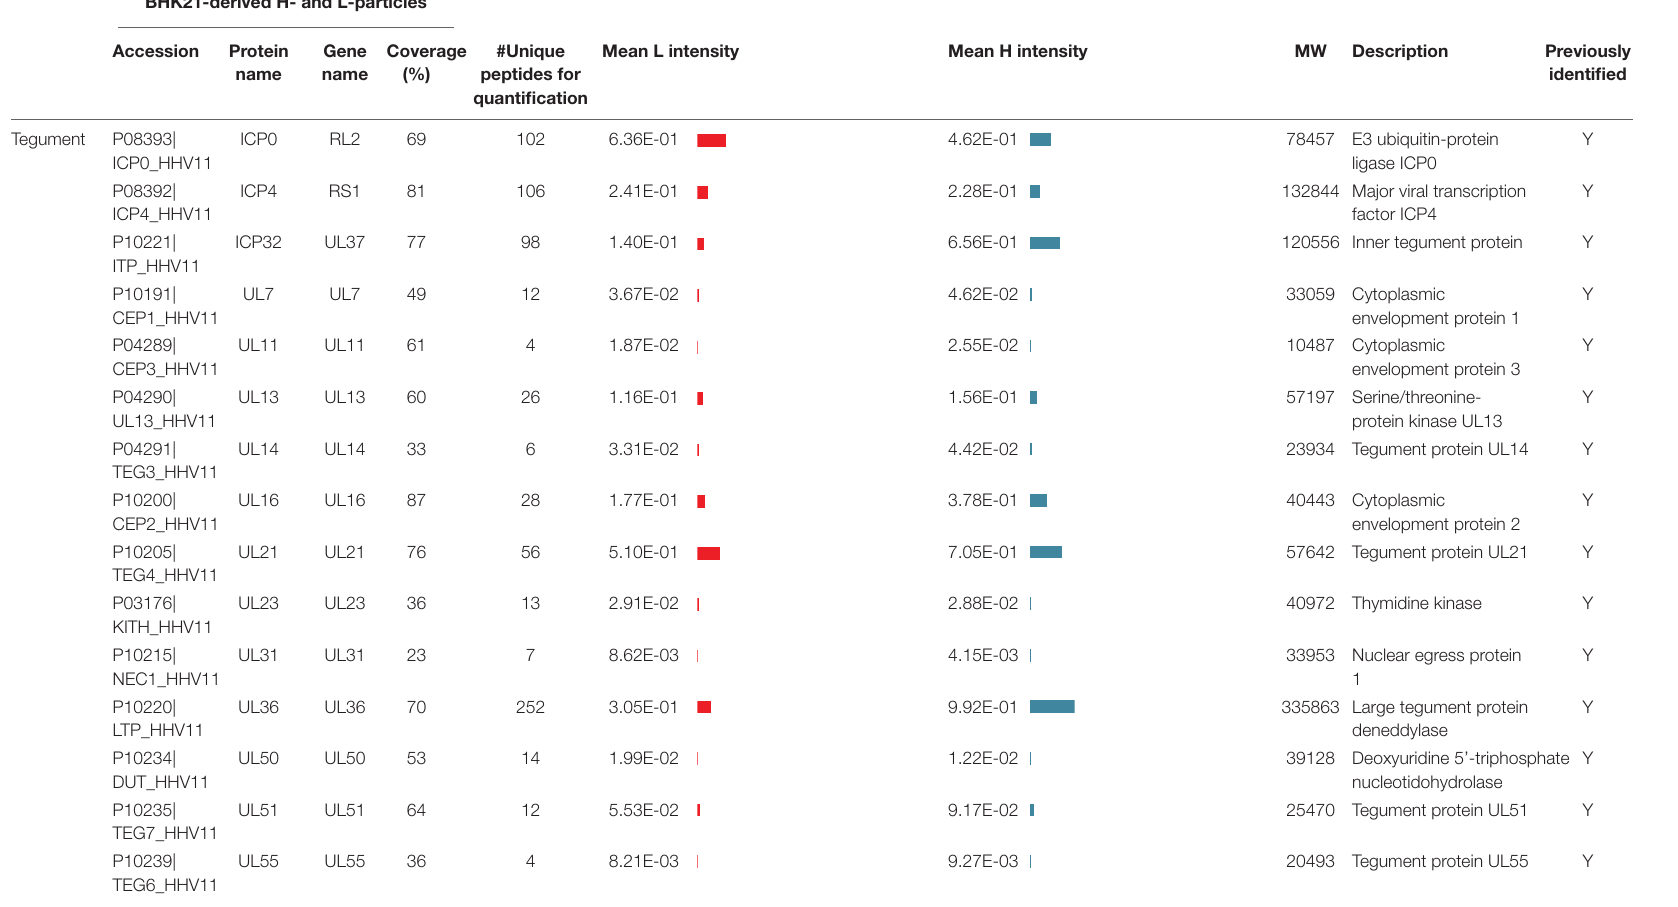
TABLE 2 | Mass spectrometric identification of viral proteins in H-particles and L-particles derived from HSV-1-infected BHK21 cells. BHK21-derived H- and